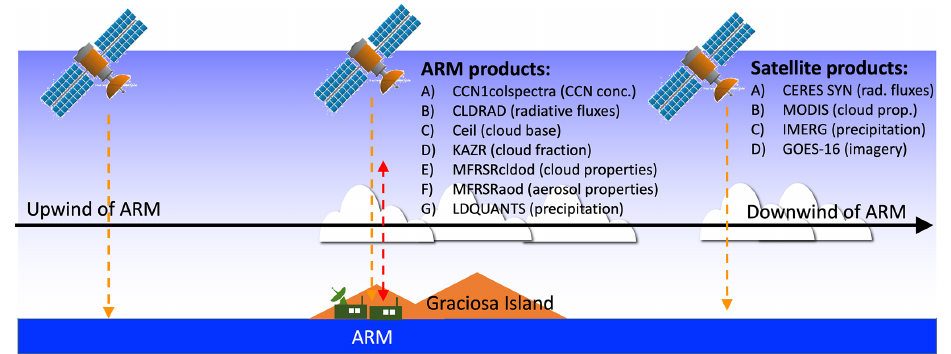
Figure 1. Information graphic showing the satellite (dashed orange arrow) and surface ARM (dashed red arrow) data sets in trajectories passing over Graciosa Island. Table 1. Summary of observational data products analyzed for the period of 22 June 2016 through 28 October